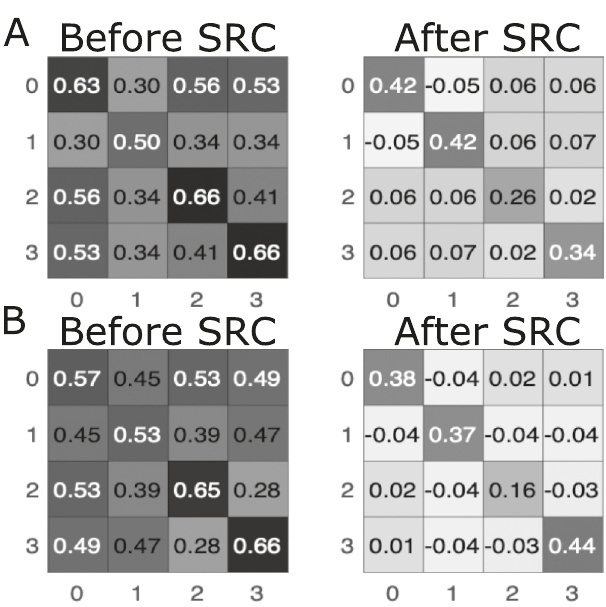
Fig. 4 | SRC reduces correlations between image classes while maintaining strong correlations within classes. Correlation matrices of activations in hidden layer1( A )andlayer2( B ).Labels(0 – 3)indicateimageclass:Task1 – 0/1,Task2 – 2/3.